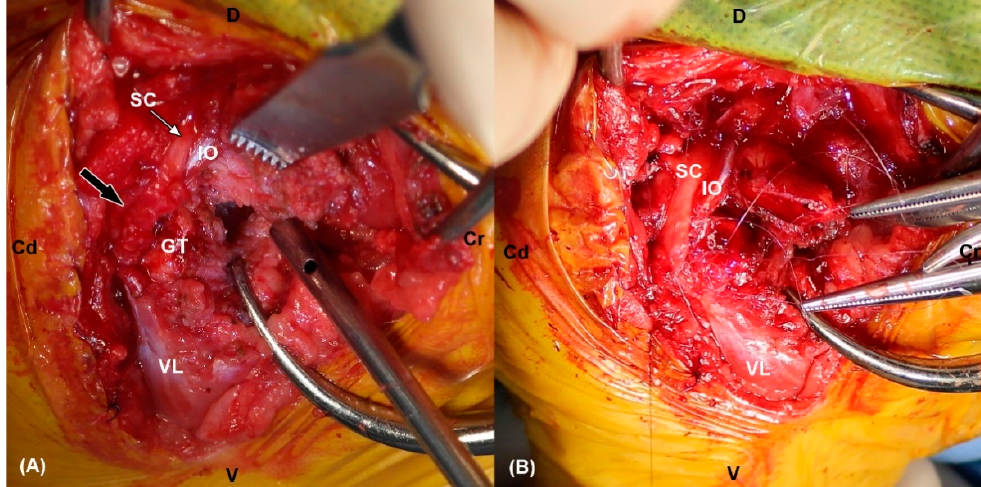
Figure 3. ( A ) The intraoperative photograph shows fibrotic (black arrow) and indistinguishable lesions of the right sciatic nerve. Note the intact proximal ending of sciatic nerve (white arrow). ( B ) Neurorrhaphy was performed by using multiple epineural sutures after debridement of the damaged nerve. SC: sciatic nerve, IO: internal obturator muscle, VL: vastus lateralis muscle, GT: greater trochanter, Cr: cranial, Cd: caudal, D: dorsal, V: ventral.